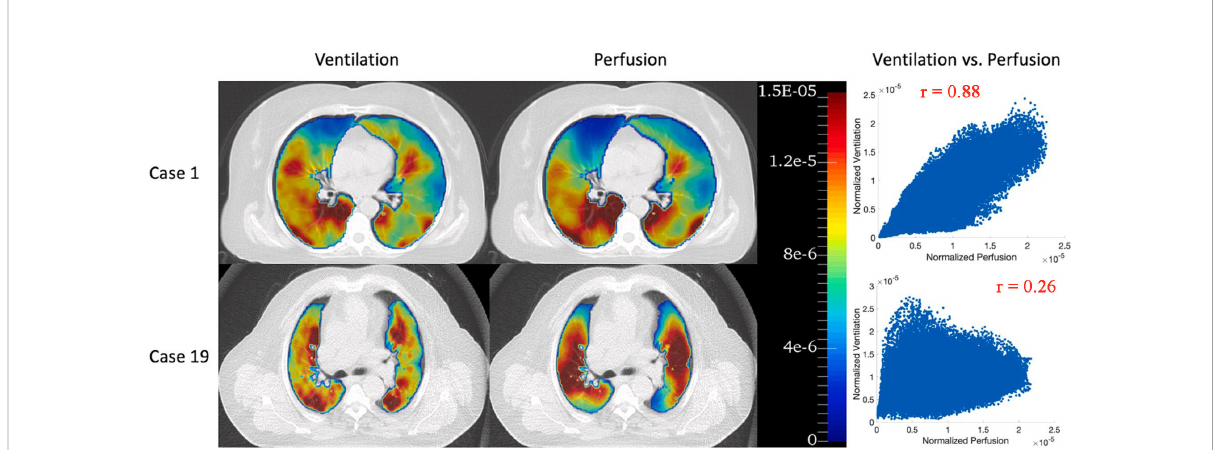
FIGURE 4 68 Ga PET/CT ventilation and perfusion images and voxel-wise correlations between ventilation and perfusion for two representative patients: case 1 with the highest correlation ( r = 0.88) and case 19 with the lowest correlation ( r = 0.26). Reproduced from reference (111) with permission from Elsevier, copyright